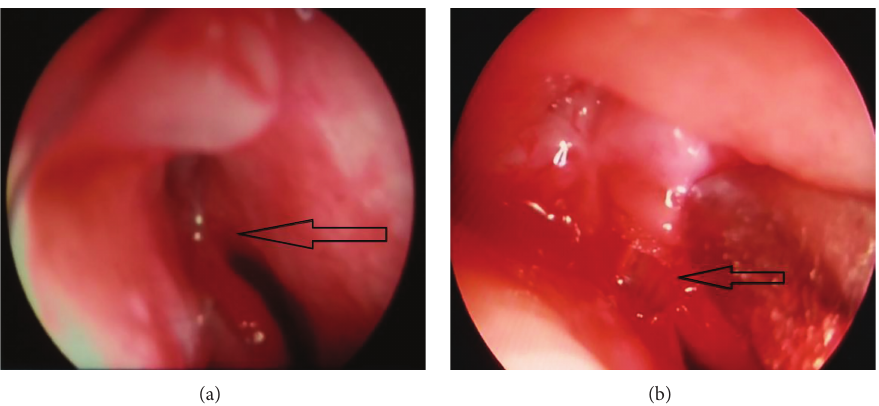
Figure 2: (a) In endoscopic imaging, it is observed that the distal end of the Medpor coated tear drainage tube is completely covered by mucosa and forms synechia with septum (arrow). (b) In the same patient, the mucosal tissue around the tube was excised and the distal end of the tube was revealed (arrow).